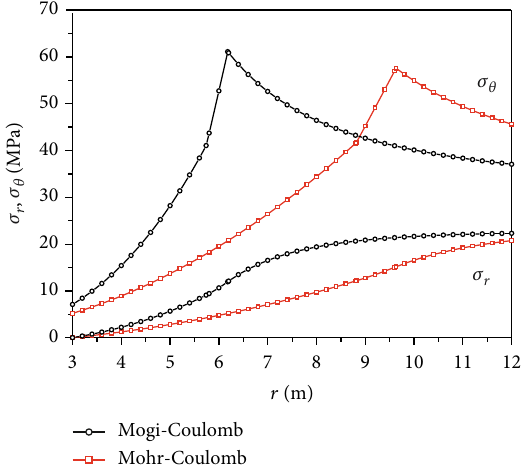
Figure 8: Comparison of stress distribution at the tunnel crown based on di ff erent strength